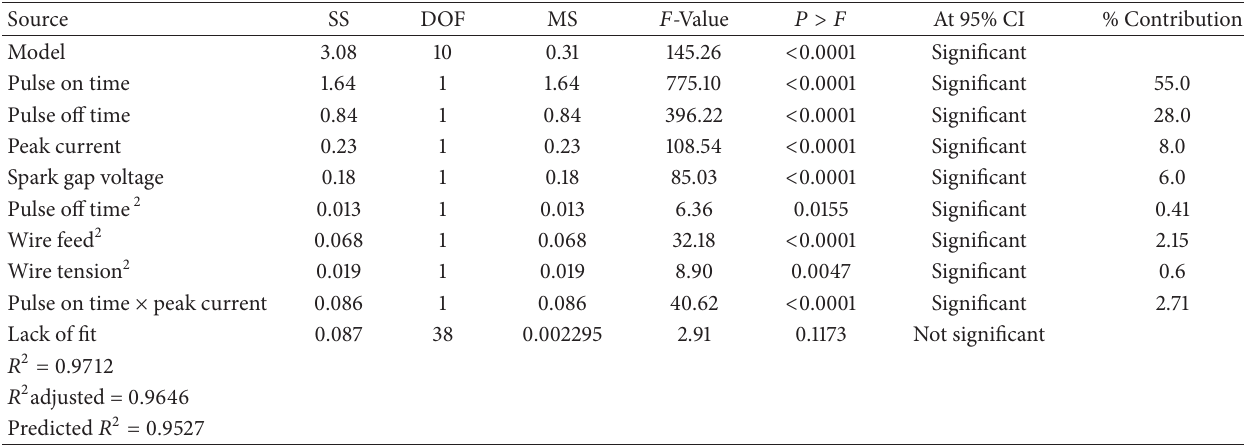
Table 5: The analysis of variance for main and interaction effects of parameters on surface